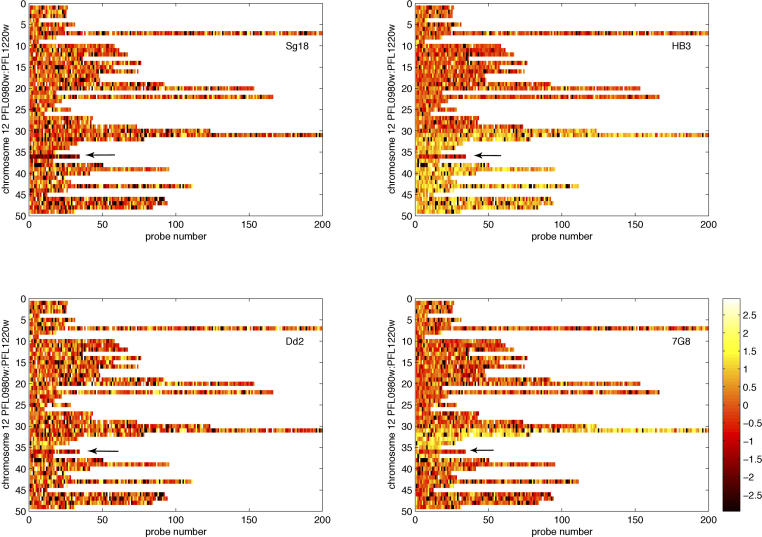
The Heat Map Shows the Base 2 Logarithm of the Ratio of the Normalized, Background Subtracted Probe Signal for the Listed Isolate (18.02, Dd2, 7G8 or HB3), Relative to the Sequenced Isolate, 3D7All probes on the array were selected to be unique within 3D7. Each horizontal bar represents a single gene on the right arm of Chromosome 12. Dark probes, with low signal intensities, do not match any region in the genome of the listed isolate, while light probes, displaying high signal intensities, such as those near the GTP-cyclohydrolase gene (PFL1155w) in Dd2, HB3, and 7G8 contain matches to multiple regions of the genome. The signal intensity and the consecutive nature of the pattern suggest that strains 7G8, HB3, and Dd2 contain more than one copy of the GTP-cyclohydrolase gene PFL1155w. An arrow represents the location of the GTP-cyclohydrolasePFL1155w gene on Chromosome 12.